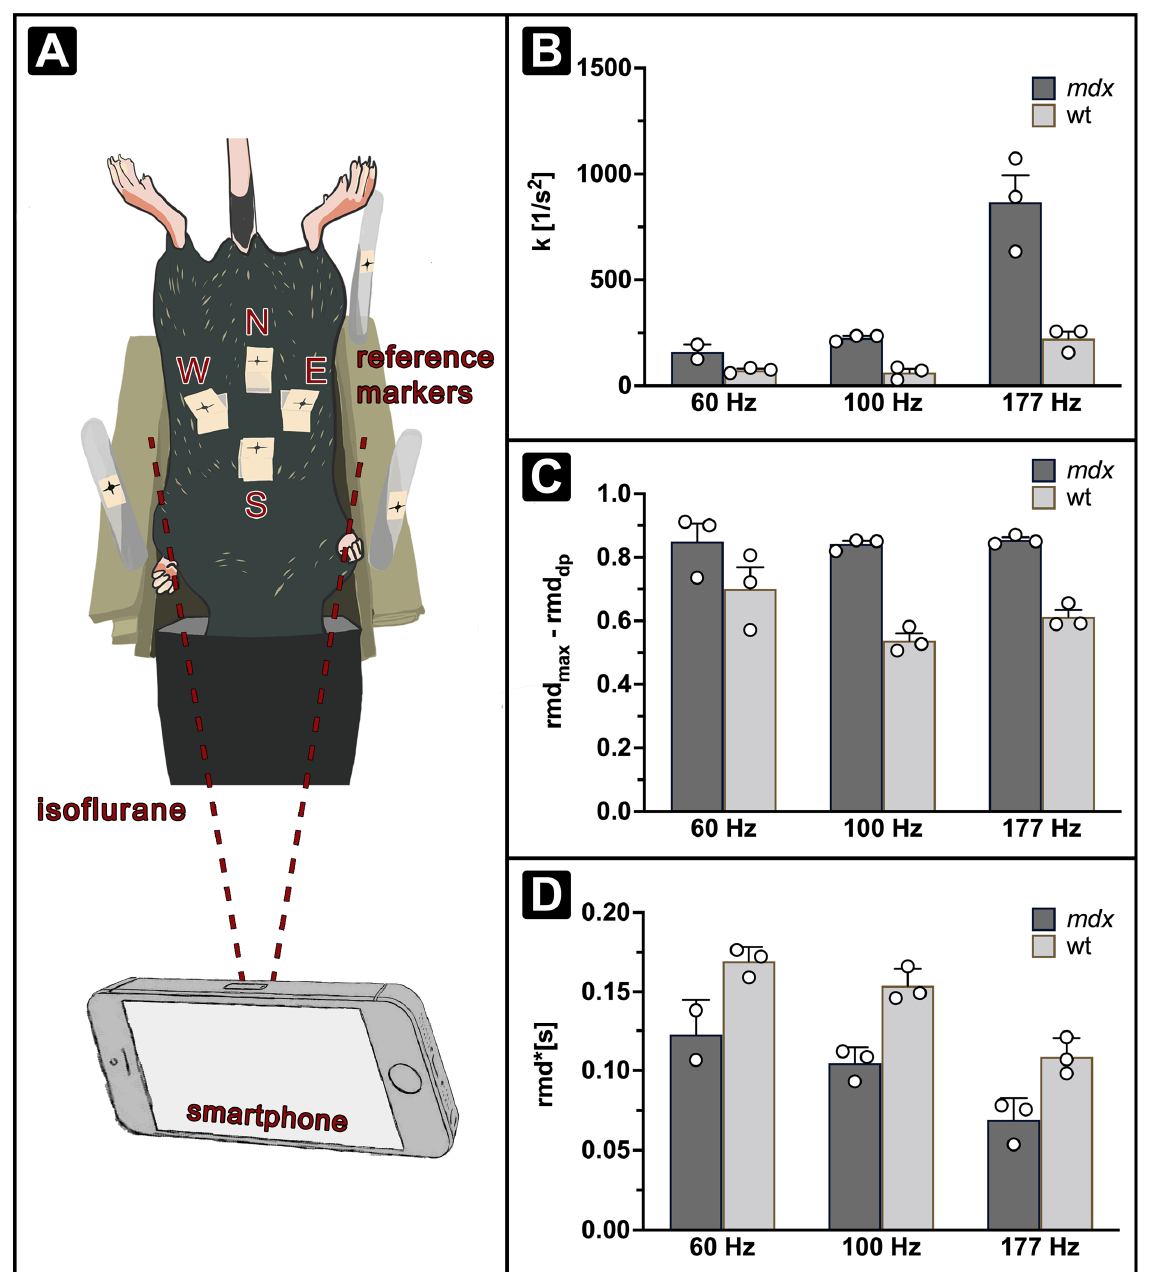
constant k (Figure 5B), relative fast expiratory phase amplitude (Figure 5C) and AuC (Figure 5D) were derived as described above from 60 and 177 Hz smartphone recordings. k has shown better segregation of the phenotypes at 177 Hz, while at 60 Hz this difference was no longer evident. Additionally, the changes in k across different recording frequencies were prominent. Amplitude of the fast expiratory phase remained segregated between phenotypes at all recorded frame rates. AuC has remained different between mdx and wt mice, similarly to k it changed across different recording frequencies.